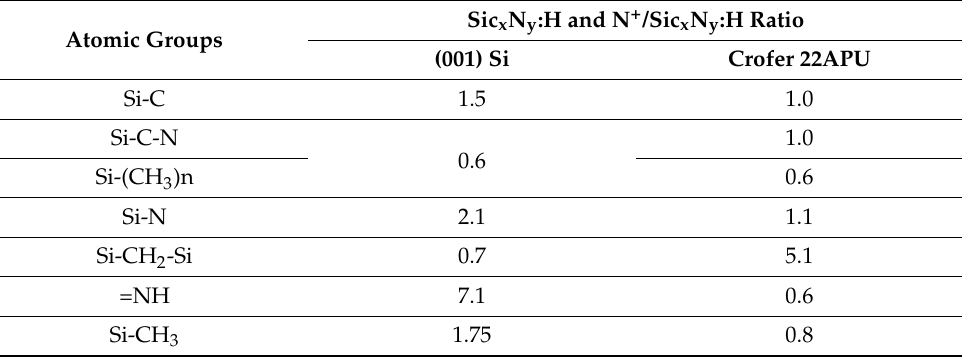
Table 3. Ratio of half-areas covering the above-mentioned bands in FT IR spectra on substrates with a layer without N + ion modification and prior N + ion modification process.